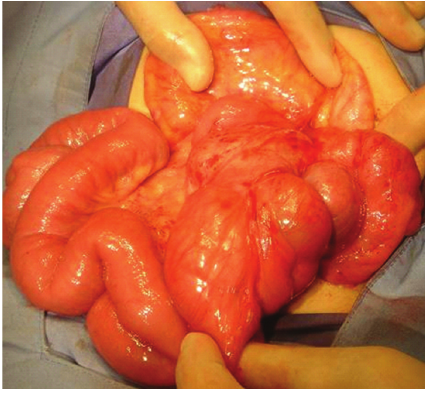
Figure 3: Patient 2; small bowel loops encased by a sac.